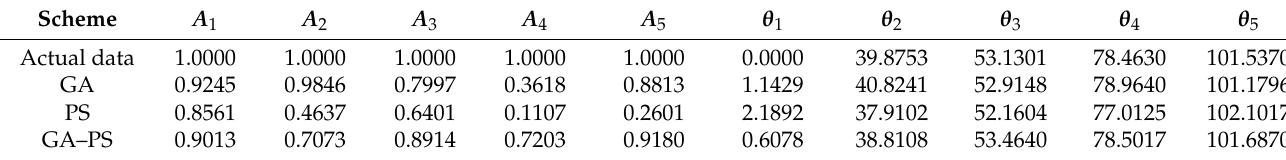
Table 12. Comparison of DOAs achieved using GA, PS, and